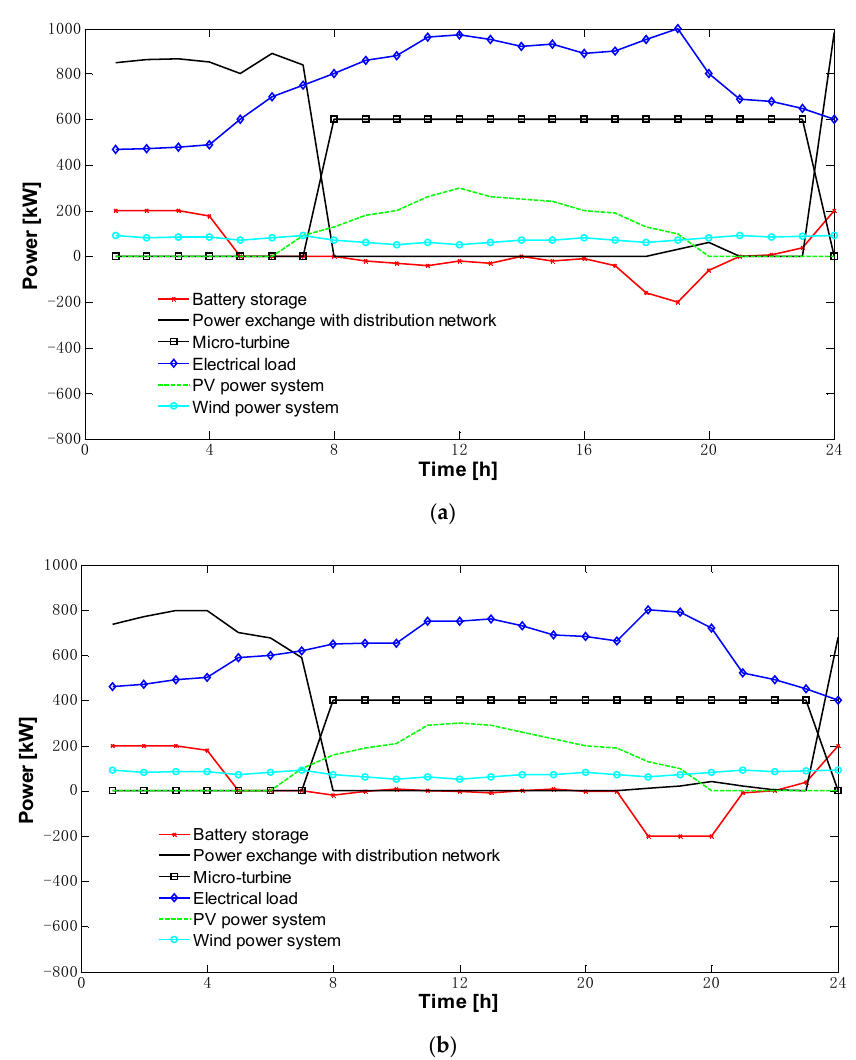
Figure 8. The electrical load balance curves of a typical day in winter ( a ) and summer ( b ) under day-ahead optimal dispatching mode.